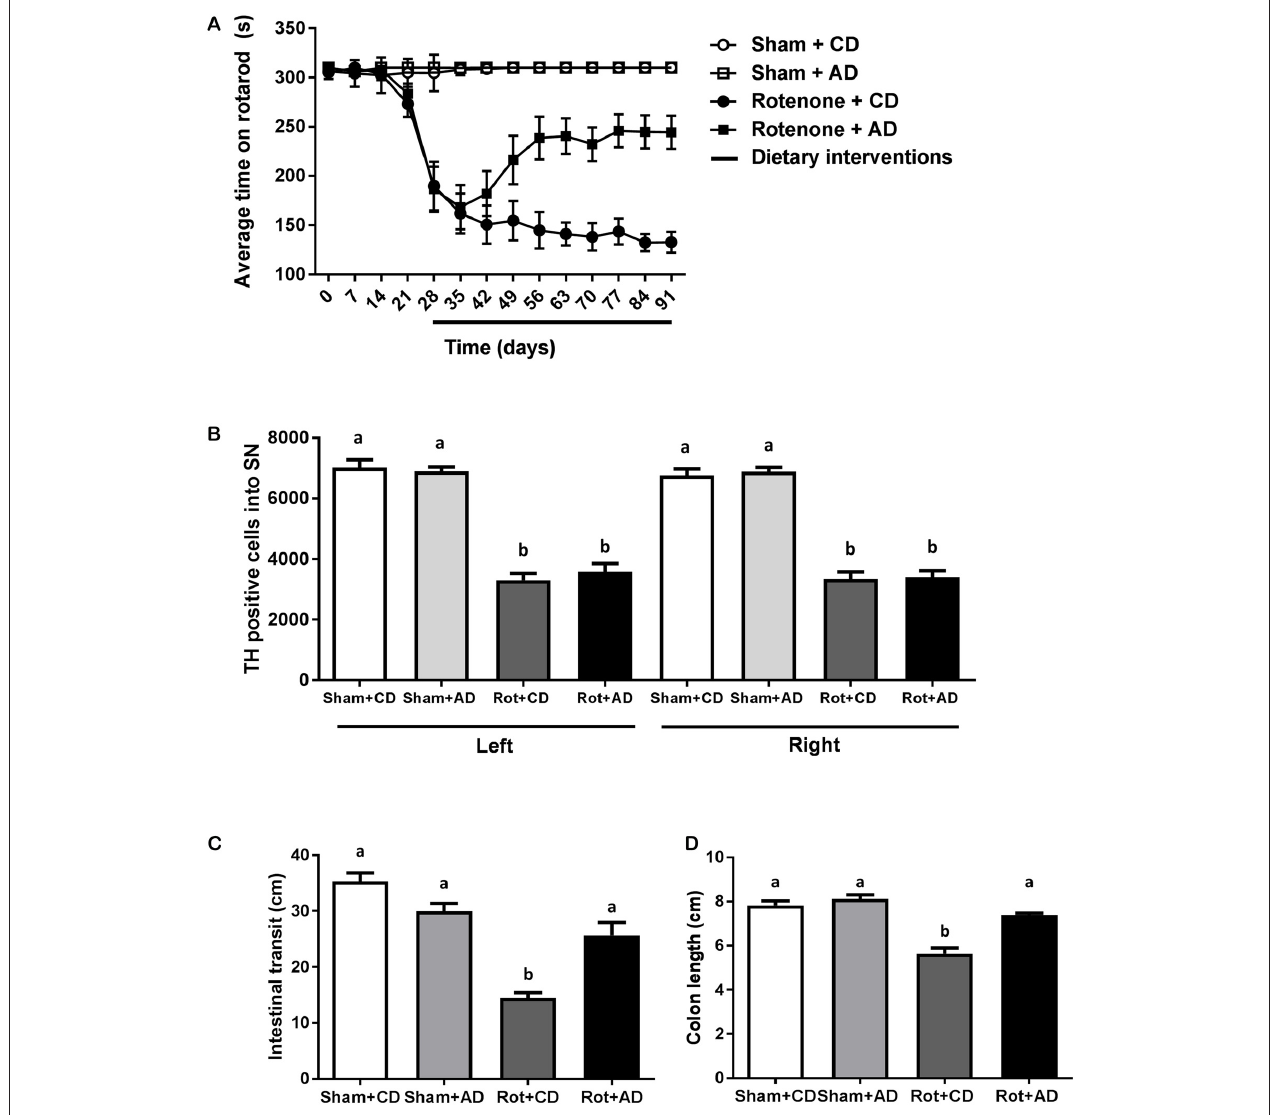
FIGURE 2 | Effects of dietary intervention started after development of full motor dysfunction on: (A) rotarod performance over the course of the experiment. Intrastriatal rotenone injection induced a clear motor dysfunction. Dietary intervention started at day 28 after surgery, i.e., after the full development of rotenone-induced motor dysfunction. As compared to Control diet (CD), the Active diet (AD) showed beneficial effects on motor function from day 56 onward, until the end of the experiment. (B) The number of dopaminergic cells indicated by the number of tyrosine hydroxylase (TH) immunoreactive cells in the substantia nigra. The dietary intervention had no effect on the number of TH positive cells. (C) Intestinal transit indicated by the total distance traveled by the Evans blue dye in the GI tract 30 min after its administration by oral gavage. The AD improved rotenone-induced delayed intestinal transit. (D) Colon length. Rotenone injection reduced intestinal transit and colon length. The AD improved rotenone-induced shortening of the colon. Data are shown as mean ± SEM. Different letters indicate mean values were significantly different ( p <